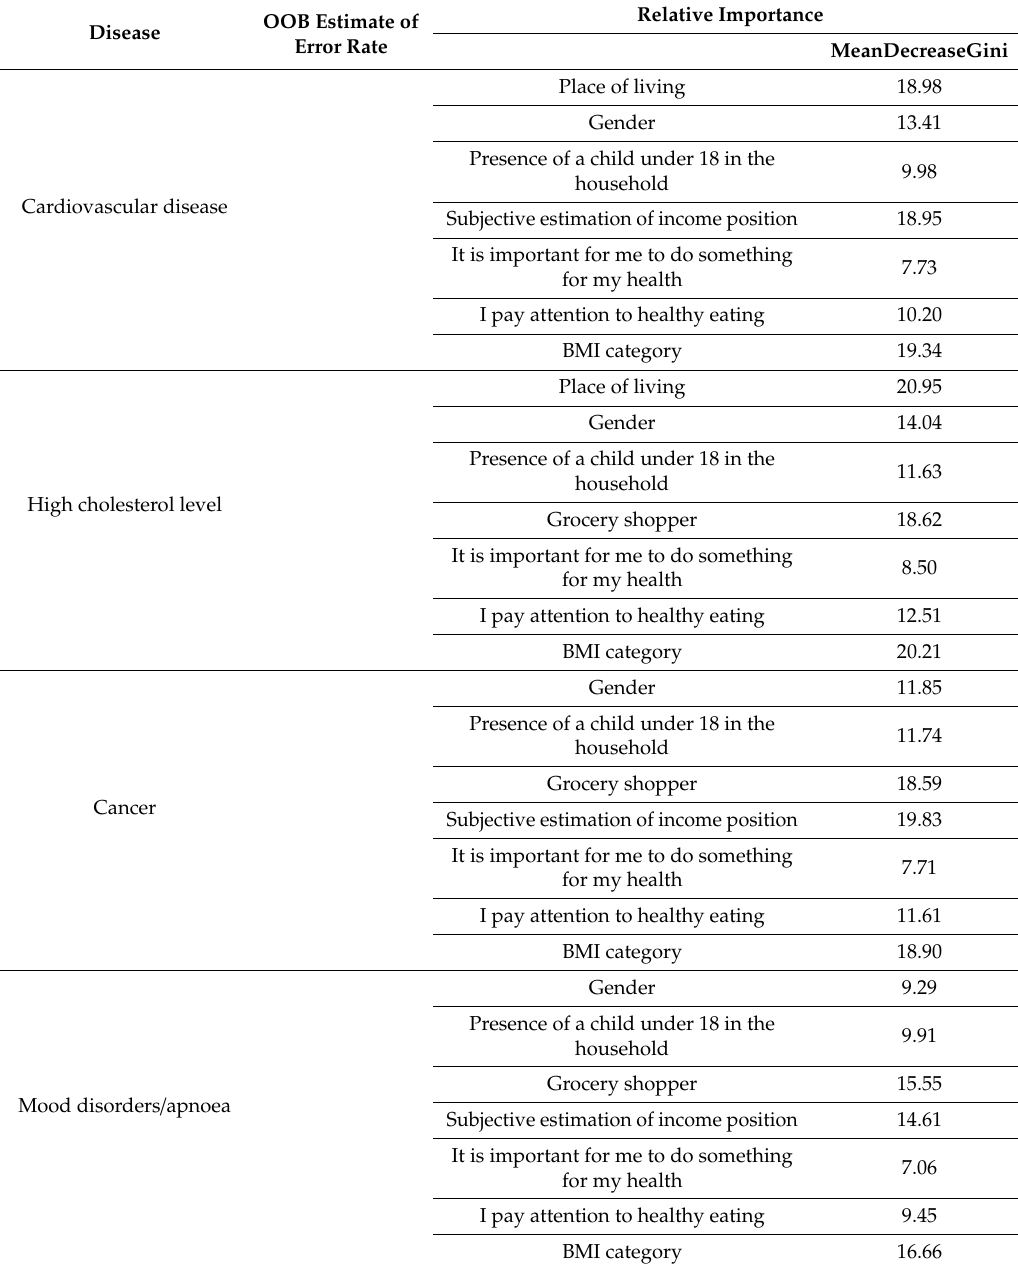
Table A2. Further results obtained with the help of random